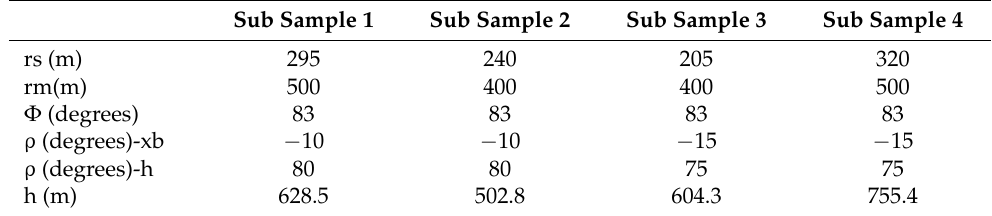
Table 3. Drone height and angle for ground data